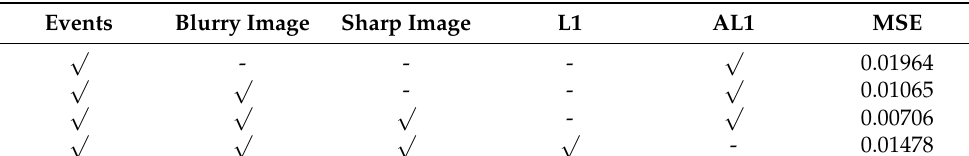
Table 3. The results of EventSRNet with different input settings and learning losses in terms of MSE. These are tested on GoPro with the × 4 spatial resolution gap between intensity the image and events. The guides from the sharp images and blurry images and the asymmetric L1 loss benefit the enhancement of events.